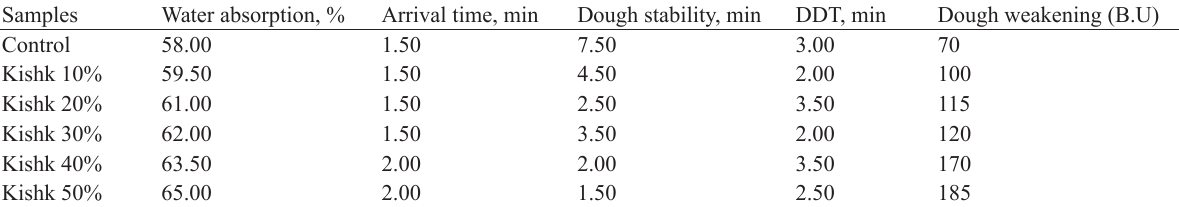
Table 3 Rheological properties of dough with and without kishk Samples Water absorption, % Arrival time, min Dough stability, min Control